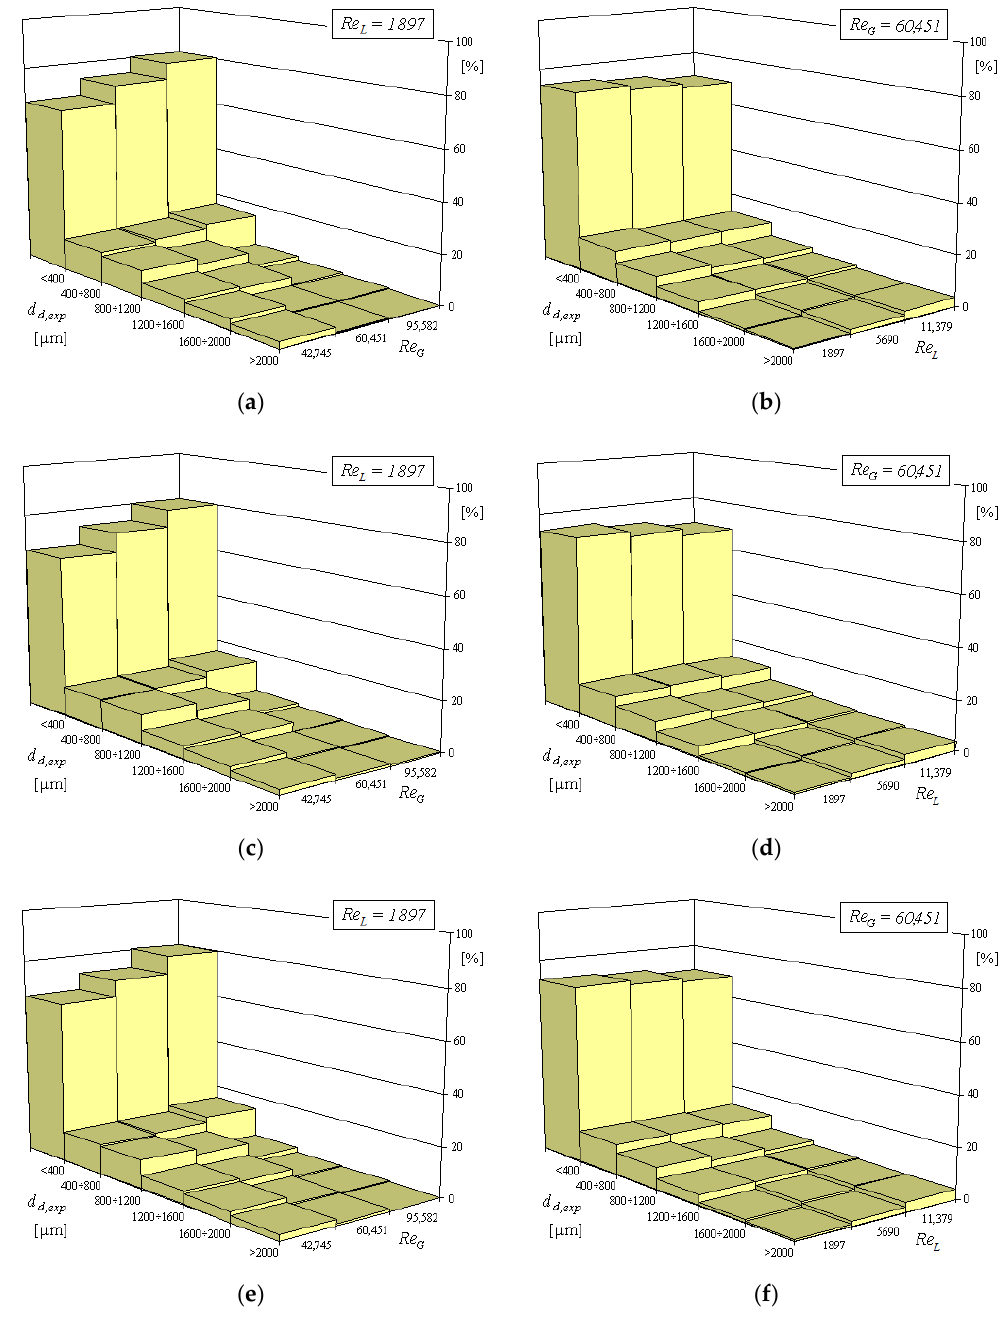
Figure 4. The distribution of drop size in the air–water system for the confusors studied: ( a,b ) K 0 ; ( c,d ) K 1 ; and ( e,f ) K 2 .